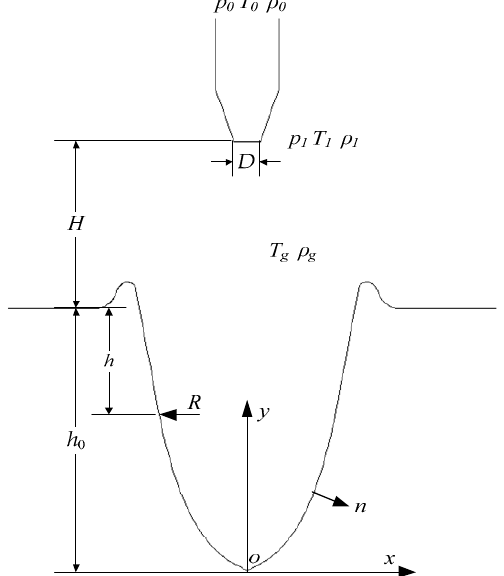
Figure 1. Diagram of the keyhole formed by a gas jet impinging on the liquid surface.